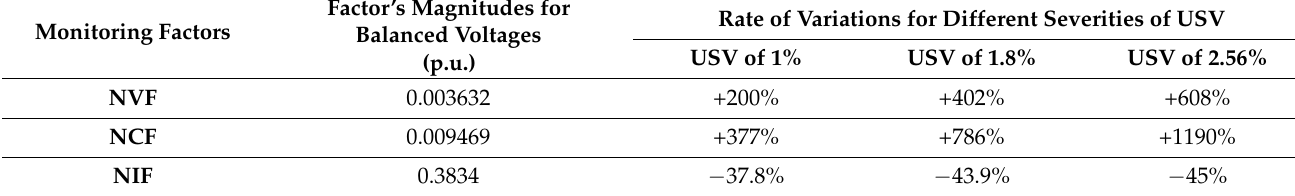
Table 3. Values of the three factors for different USV’s